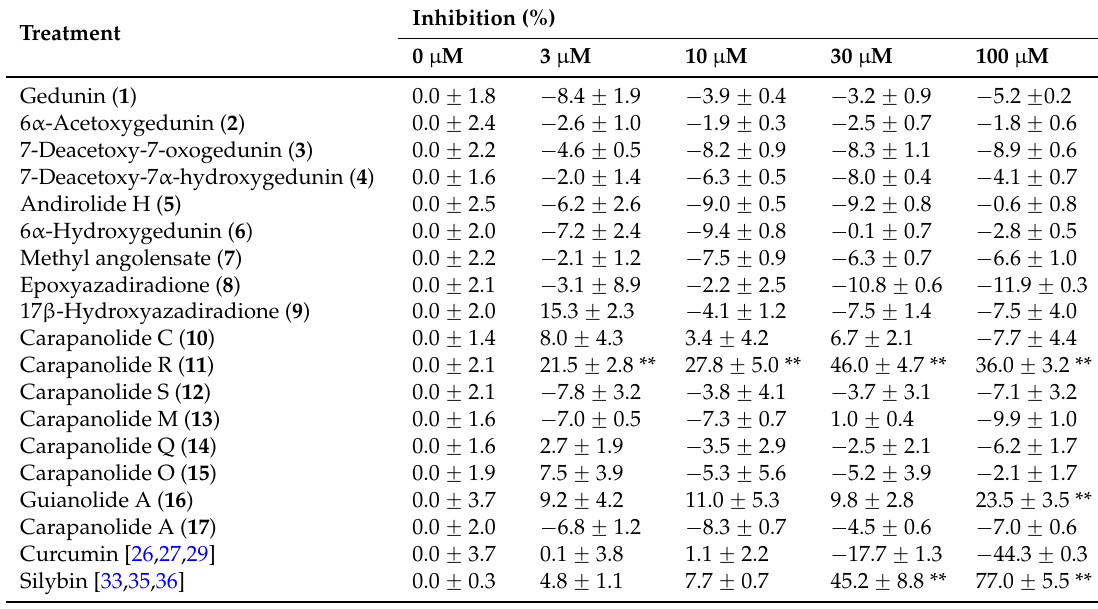
Table 2. Inhibitory effects of limonoids ( 1 – 17 ) on D -GalN-induced cytotoxicity in mouse primary hepatocytes.